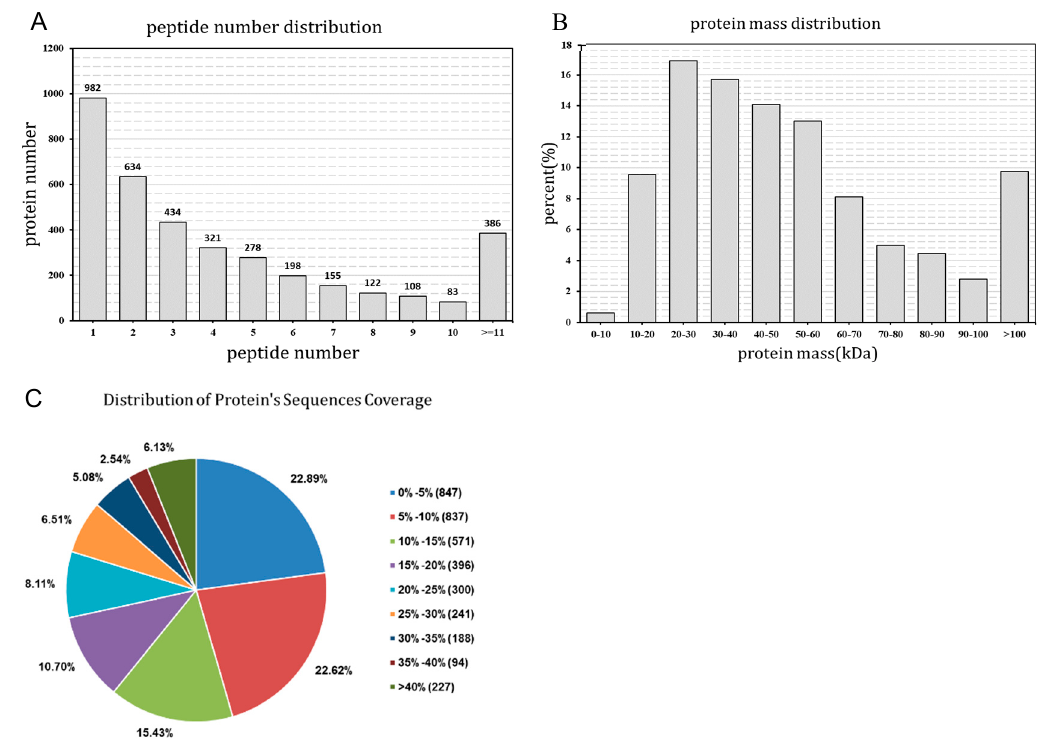
Figure 2. Identification and quantitative evaluation of identified proteins, including the distribution of the peptide numbers identified by Proteome Discoverer ( A ), the distribution of identified proteins according to molecular mass ( B ), and the distribution of protein sequence coverage ( C ).